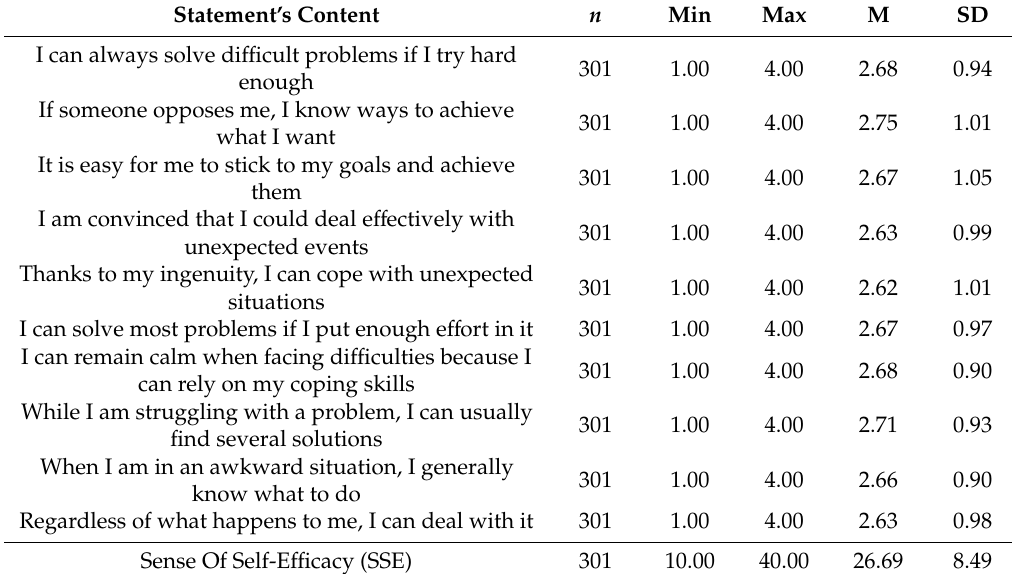
Table 3. Distribution of respondents’ answers to individual statements of the GSES.